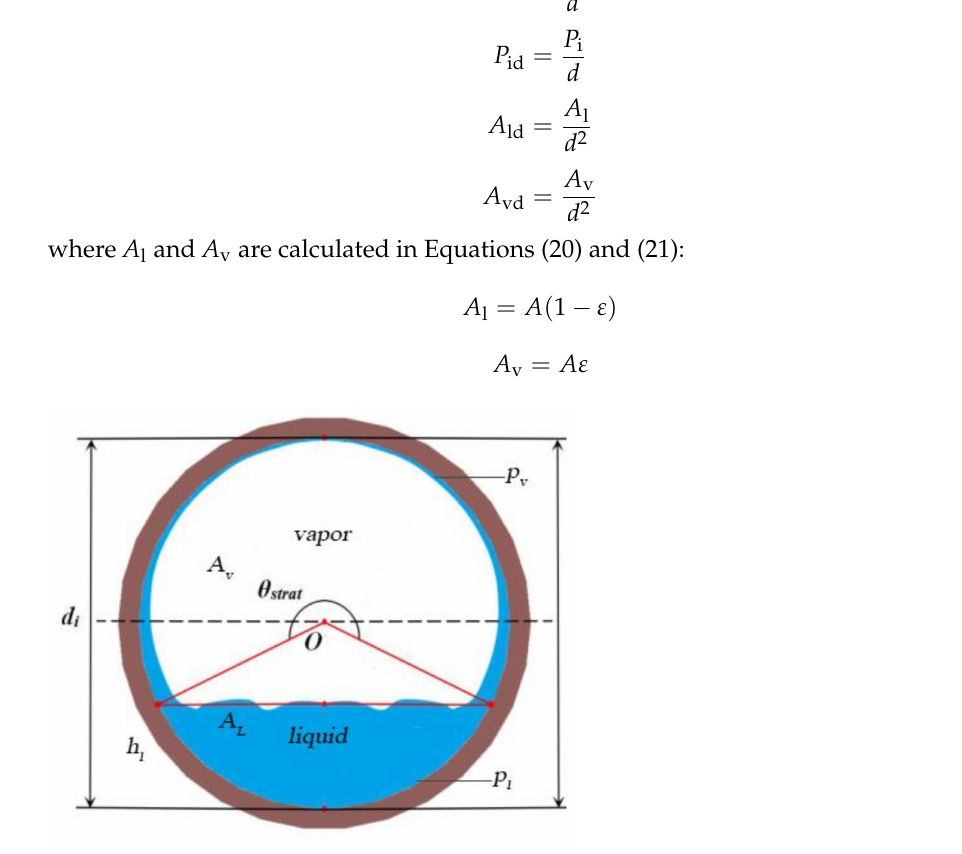
Figure 9. Geometric parameters of two-phase flow in the heat exchange